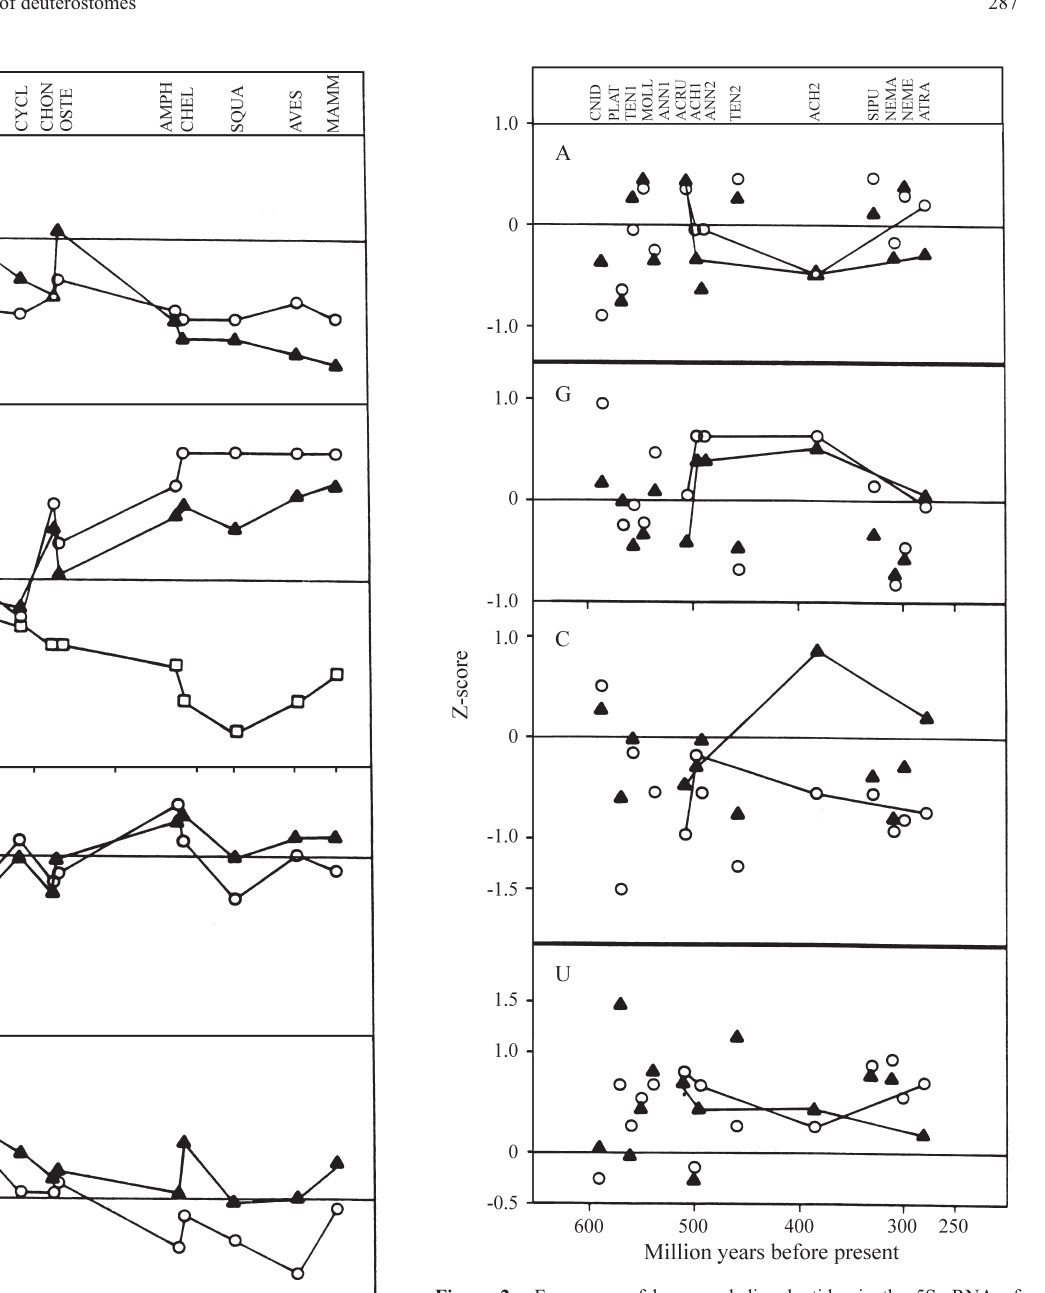
pseudogenes. Gene sequences showed a higher rate (10x) of A → G transitions than pseudogenes (7 x) and reversed